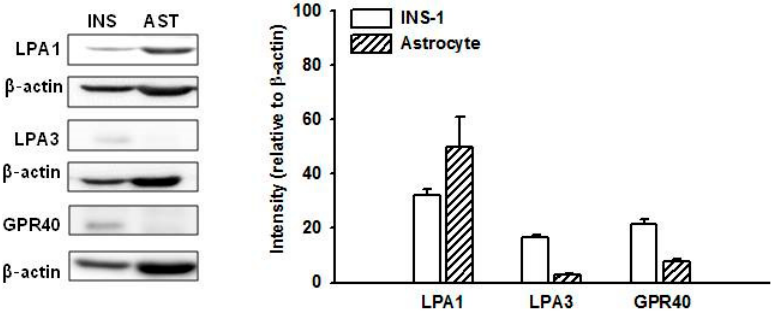
Figure 2. Expression of LPA1, LPA3, and GPR40 in INS-1 cells and mouse astrocytes. Cell lysates were subjected to immunoblotting using antibodies against LPA1, LPA3, and GPR40. The expression of each receptor relative to β -actin was plotted. Data represent means ± SD ( n = 4). INS, INS-1 cells; AST, mouse astrocytes. LPA: lysophosphatidic acid.